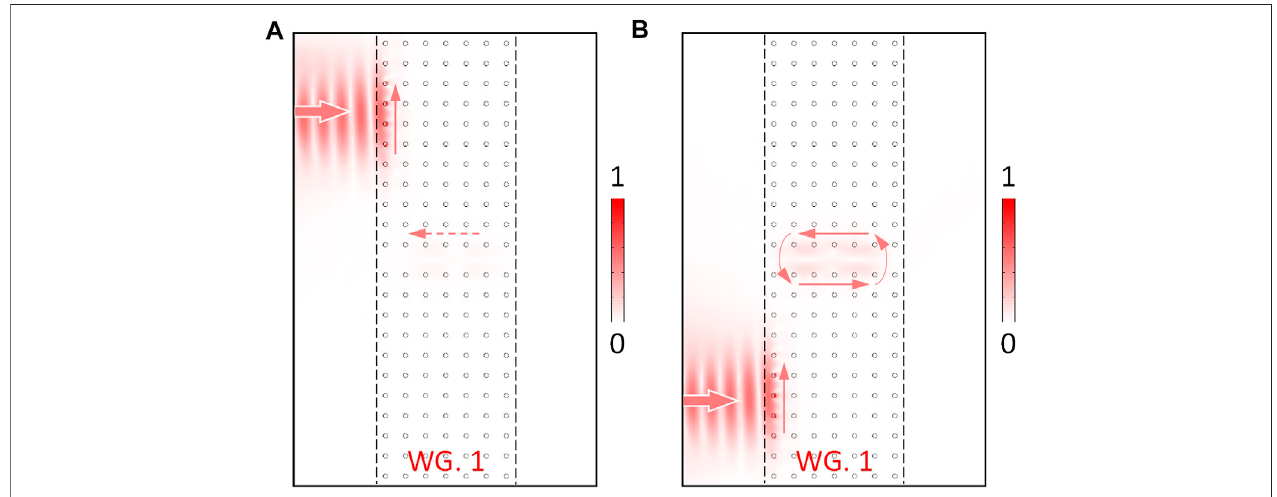
FIGURE 7 | Remotely and non-reciprocallyexciting slow light state. The rough arrows represent the transmission direction of the incident plane wave, and the thin arrows indicate the propagating direction of topological one-way edge states.